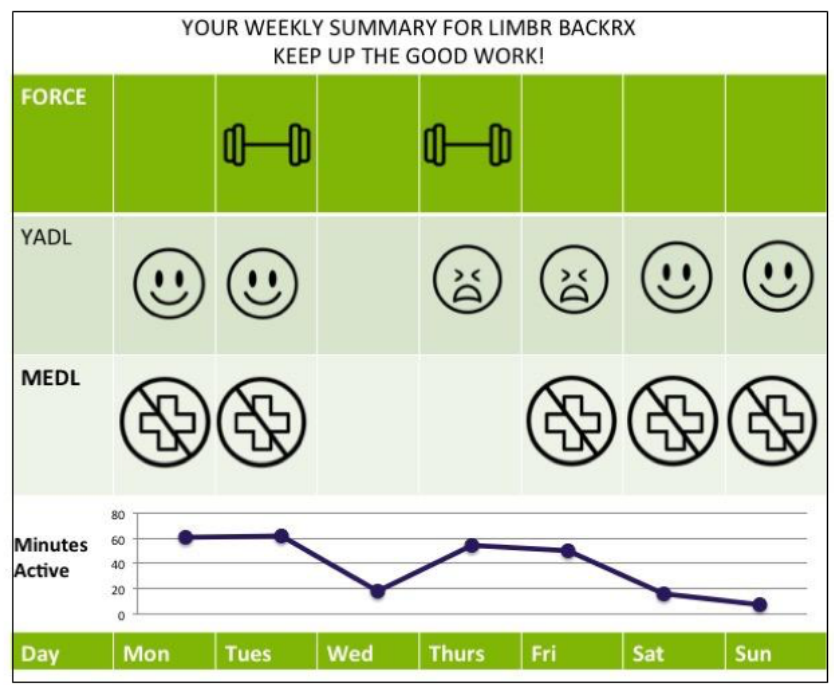
Figure 4. Example of a weekly summary